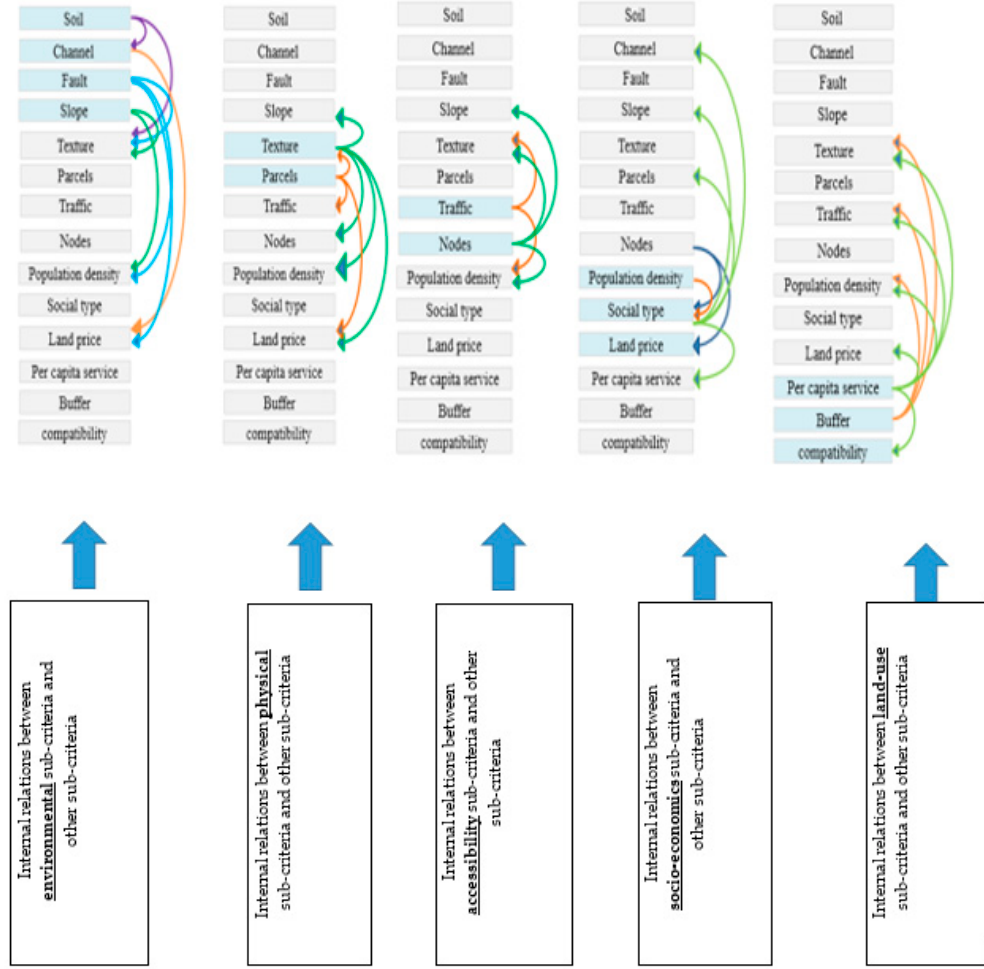
Figure 3. The internal relations between the sub-criteria, based on expert opinion . In this figure, the relationships between each of the sub-criteria (related to the five criteria introduced in Figure 2) with other sub-criteria related to other categories are demonstrated (The colors in this figure are simply due to the better readability of the relationships between the criteria and have no special meaning).